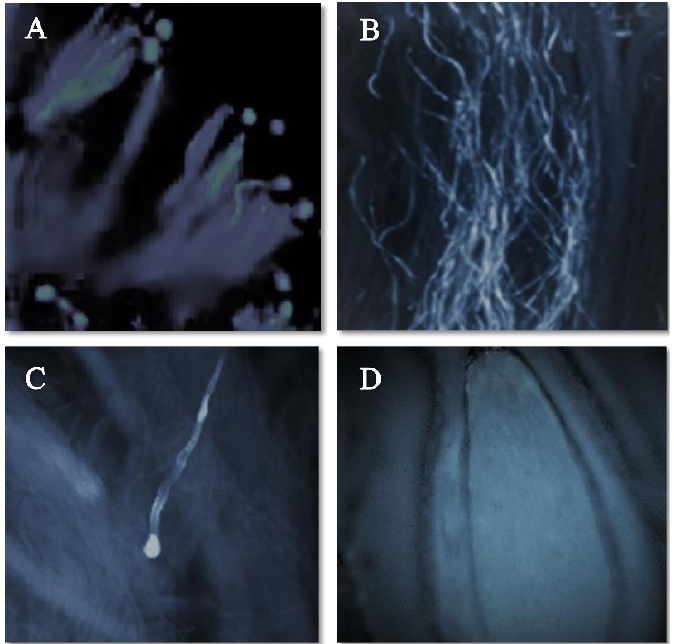
Figure 3. Pollen germination and pollen tube growth in pistil of the cultivar ‘Satluj Purple’ under Self-pollination (magnified 200 × ). ( A ) Pollen germination at stigmatic surface; ( B ) Pollen tube growth in the upper half of the style; ( C ) Inhibition of Pollen tube growth in the upper third portion of the style; ( D ) No entry of pollen tube in ovary region.